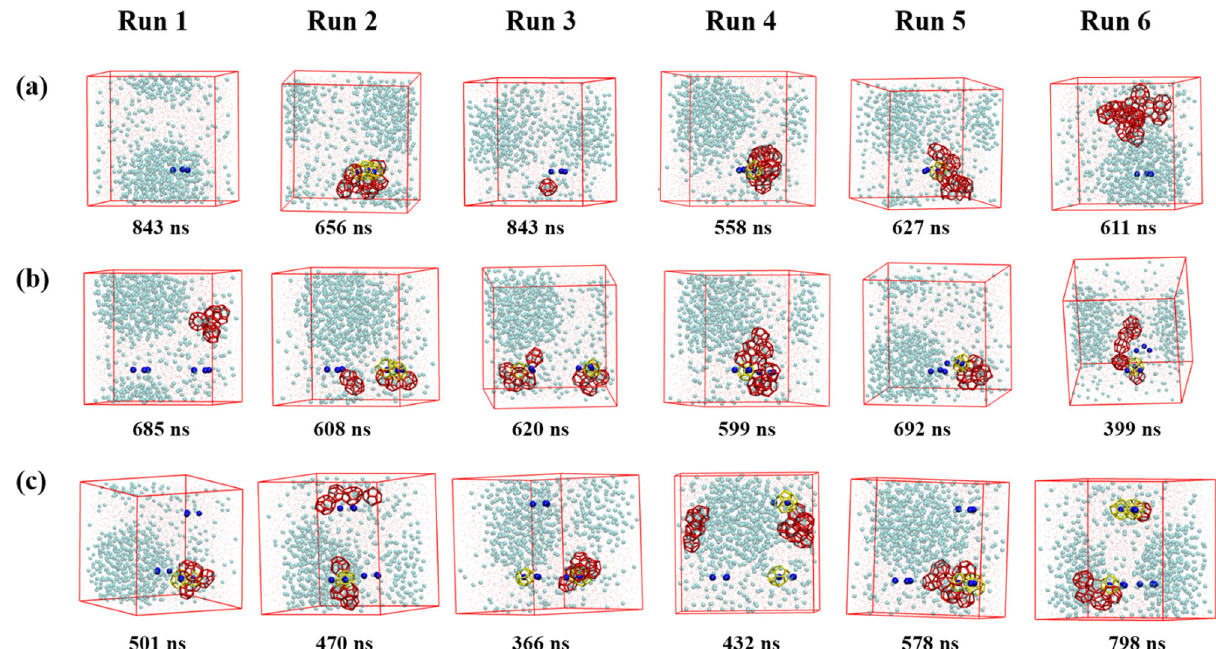
Fig. 7 Effects of three-body aggregates on hydrate nucleation sites. Different number of three-body aggregates were added into the initial con fi guration and the corresponding numbers of methane molecules were removed to ensure the consistency of the number of molecules in the system. The methane molecules in the three-body aggregates were fi xed during simulation to keep their aggregation patterns. For each system, six independent runs were performed. a – c display the results for systems with one, two and three three-body aggregates, respectively. The snapshots when the number of hydrate cages becomes larger than 10 are present. If the number of hydrate cages is always smaller than 10, the snapshot at fi nal status is provided. The blue balls represent methane molecules in the three-body aggregates. The simulation boxes are rotated for clarity. The hydrate cages which central methane is a part of the three-body aggregate is marked in yellow; otherwise, the cages are drawn in